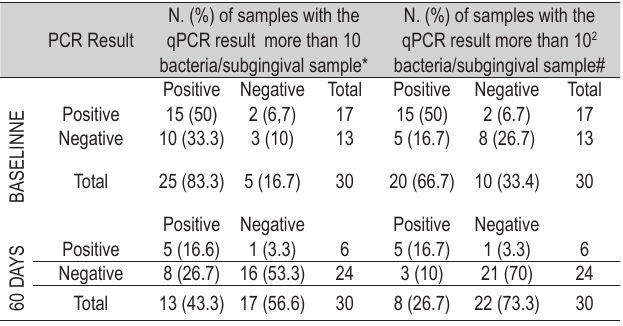
Table 3 - Comparison between PCR and qPCR for the detection of P. endodontalis